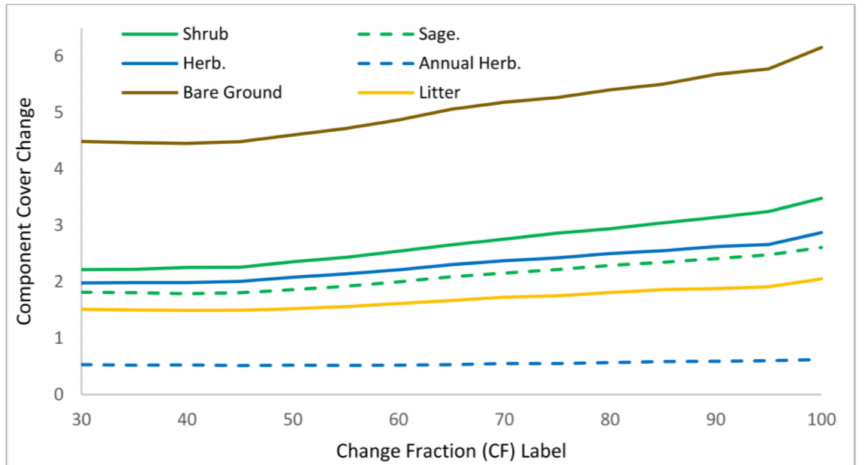
Figure 10. Change Fraction (CF) sensitivity to fractional component change in WRS path/row 37/31 (southwest Wyoming). Mean of the absolute fractional component change between base and target years by CF confidence level. Data are from across unburned portions of the path/row and span all target years from 1985 to 2018. CF values less than 30 are not displayed because no labeled change can occur below this